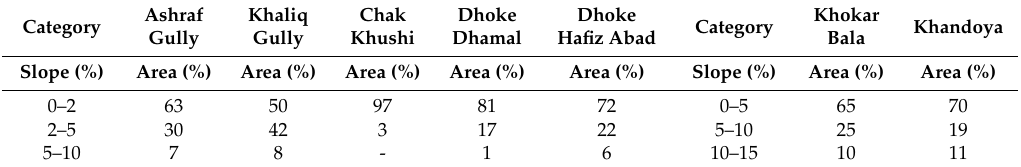
Table 5. The areas under di ff erent slopes in small watersheds of the Chakwal and Attock districts. Category